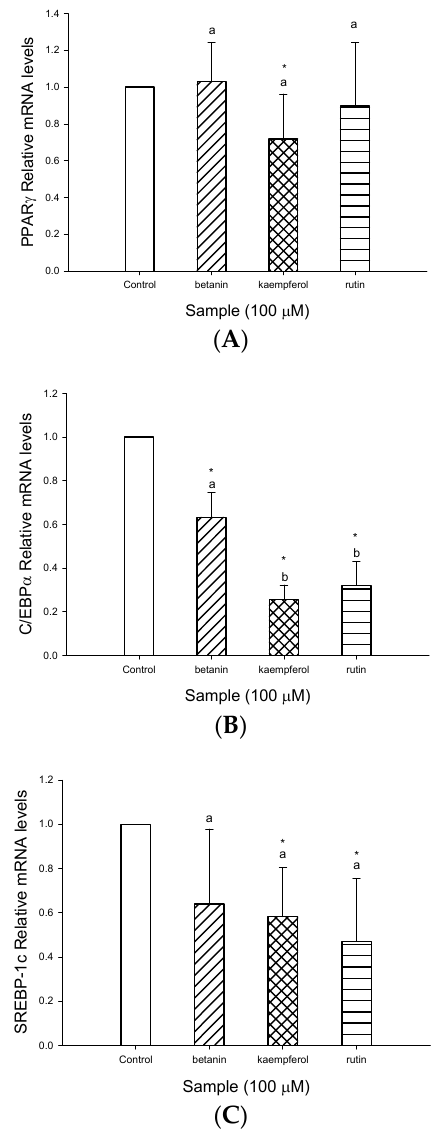
Figure 5. Effects of of rutin, kaempferol and betanin on expression of adipogenic genes. ( A ) The effect of rutin, kaempferol and betanin on gene levels of PPAR γ in 3T3-L1 cells. The cells were incubated with rutin, kaempferol or betanin, respectively, for 6 h. ( B ) The effect of rutin, kaempferol and betanin on gene levels of C/EBP α in 3T3-L1 cells. The cells were incubated with rutin, kaempferol or betanin, respectively, for 12 h. ( C ) The effect of rutin, kaempferol and betanin on gene levels of SREBP-1c in 3T3-L1 cells. The cells were incubated with rutin, kaempferol or betanin, respectively, for 12 h. Data are expressed as the mean ± SD of three independent experiments. * ( p < 0.05), compared to the control. Values in each concentration with different superscript letters are significantly different ( p < 0.05).